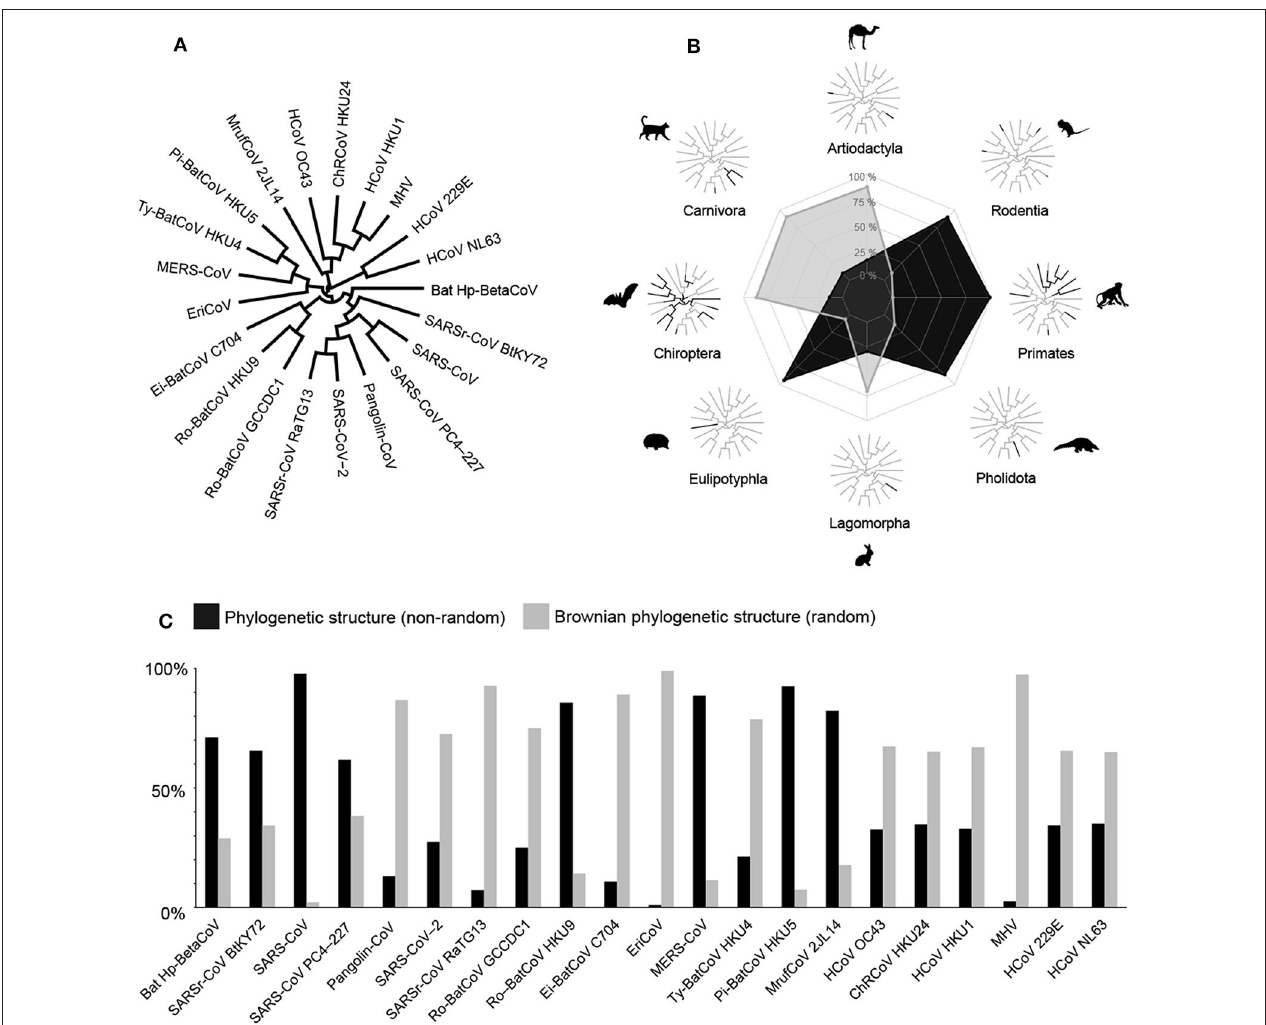
FIGURE 1 | Phylogenetic relationships between coronaviruses and their mammalian hosts. (A) Full genome tree of 21 CoVs. (B) Maximum-likelihood ancestral state reconstructions for eight mammalian host orders by stochastic character mapping (SIMMAP). Radar chart shows the variation (%) between Phylogenetic and Brownian structure evolution of CoVs in mammalian orders. (C) Proportional differences of Phylogenetic and Brownian structure variation (%) in the evolutionary history of CoVs on the time-calibrated phylogeny of